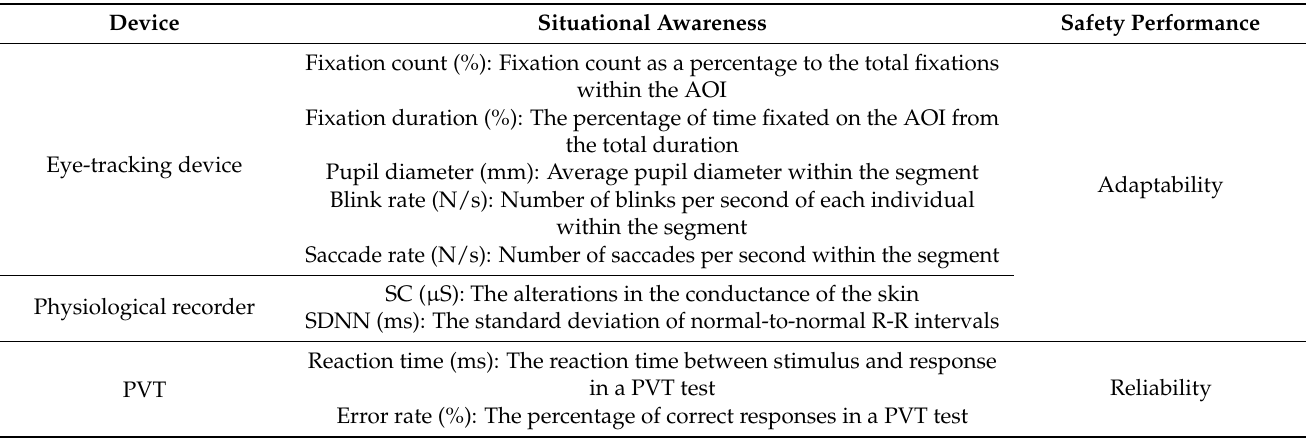
Table 1. Index system on controller’s situational